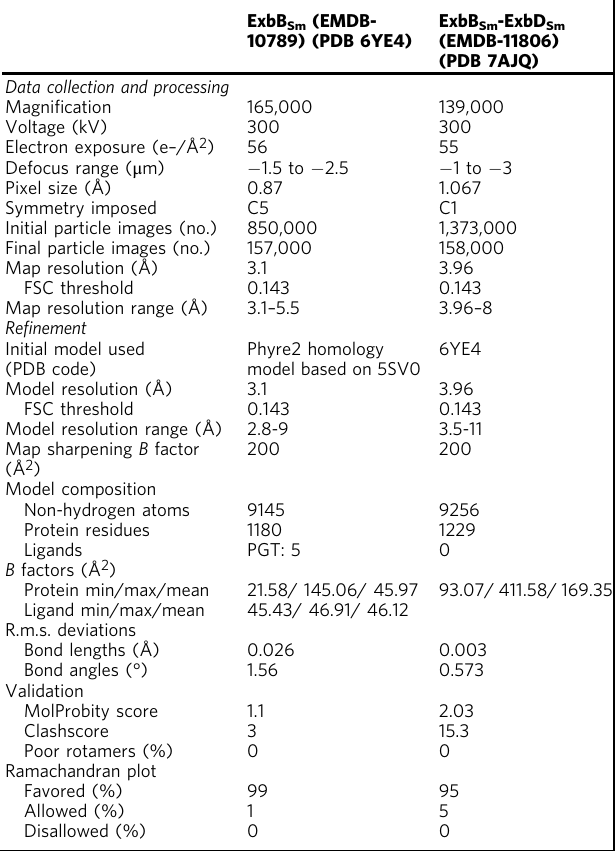
Table 1 Data collection, processing, and re fi nement statistics for ExbB Sm and ExbBD Sm